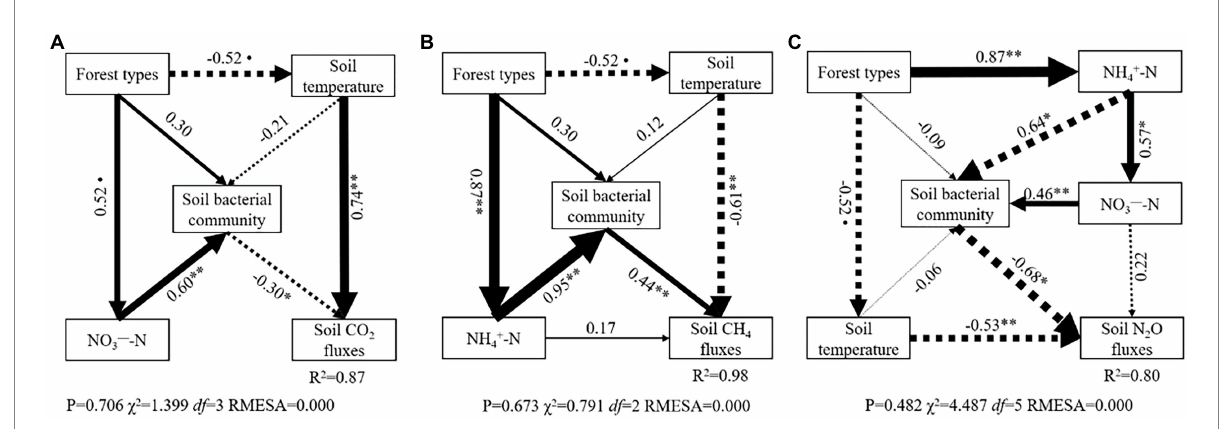
FIGURE 6 Structural equation model (SEM) depicting the effect of forest types on soil CO 2 (A) , CH 4 (B) , and N 2 O (C) fluxes. Single arrows represent direct linear causal relationships. Numbers beside arrows are standardized path coefficients. Arrow width is proportional to the size of the standardized path coefficients. Solid and dotted arrows indicate positive and negative relationships, respectively. The arrow width is proportional to the strength of the relationship. R2 denotes the proportion of variance explained by SEM. * and ** represented the significant correlation at p < 0.05 and p < 0.01